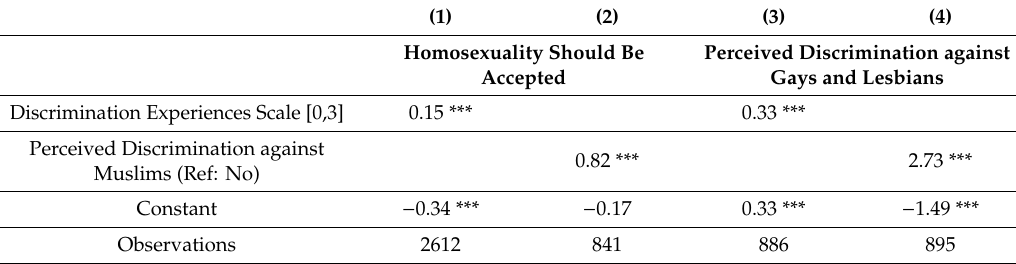
Table A2. Coe ffi cients from Logistic Regression Predicting Solidarity with Gays and Lesbians.